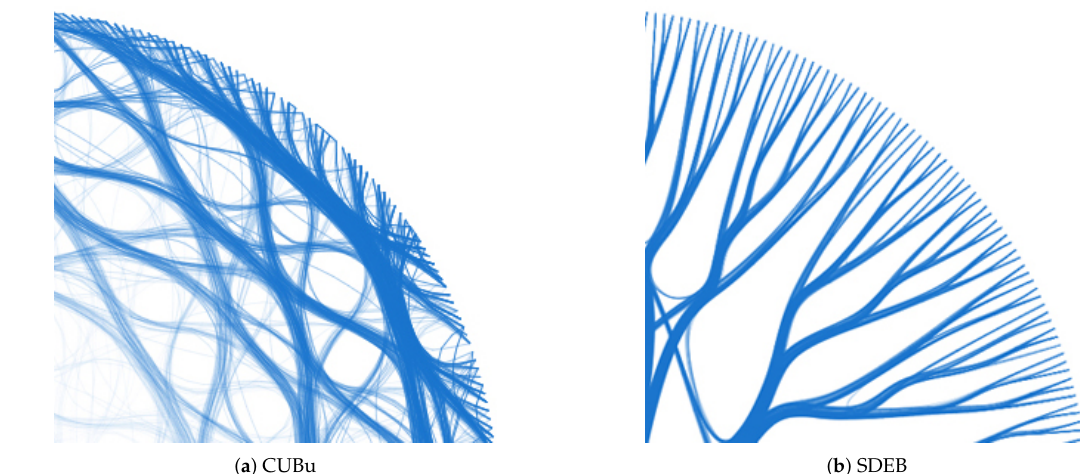
Figure 7. A zoomed in part of the visualization produced by the techniques CUBu and SDEB. CUBu bundles all edges close to their source/target vertices, resulting in misleading bundles. SDEB draws edges following a direction perpendicular to the tangent of the radial layout, with the bundling happening at different